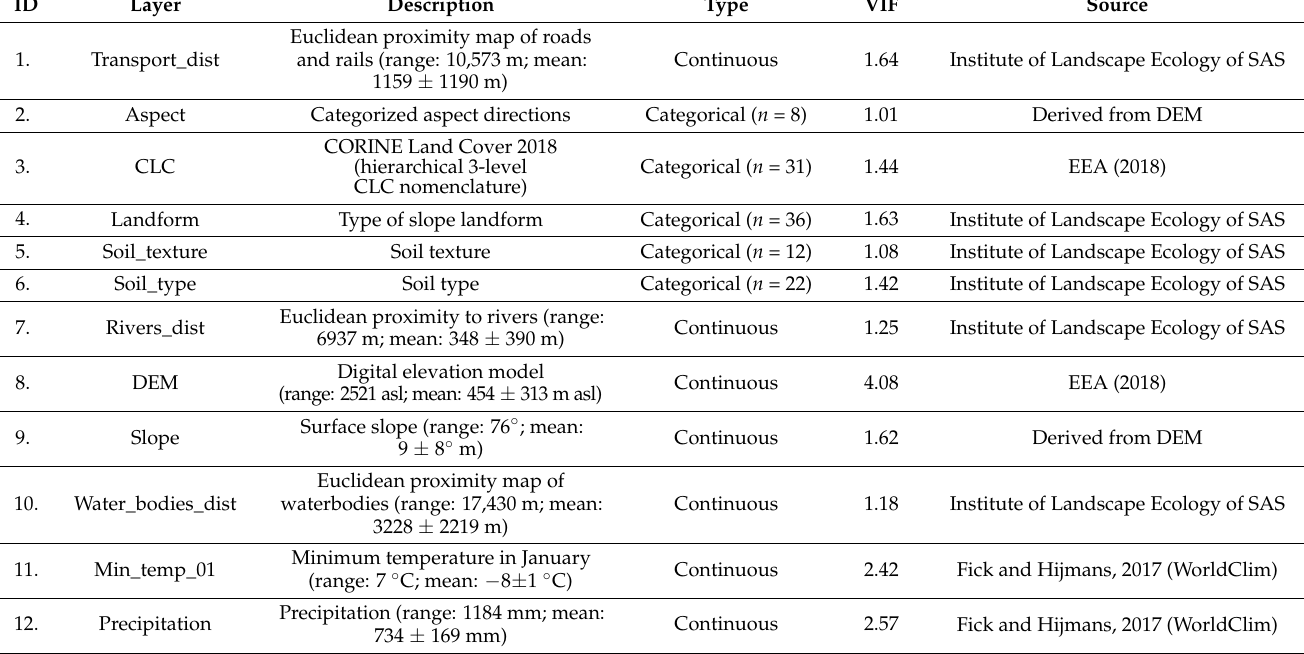
Table 3. List of used environment variables with variable inflation factor